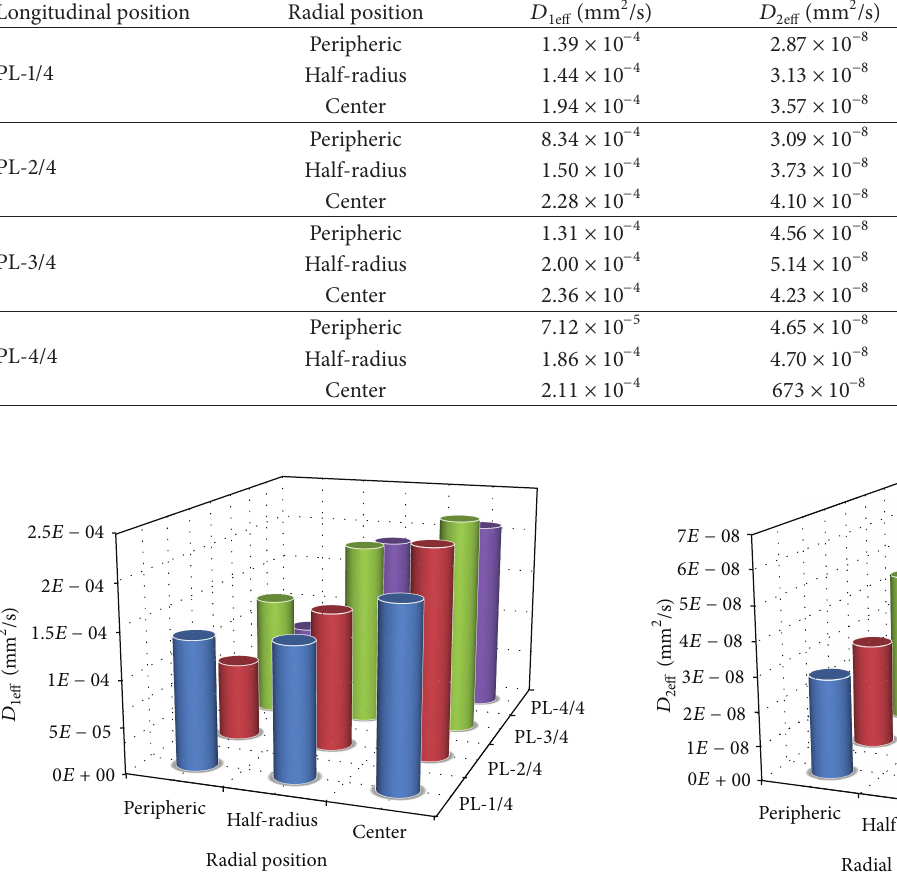
Figure 7: Summary of the effective diffusion coefficient of Raffia vinifera fibres during the initial phase of water absorption along the stem.